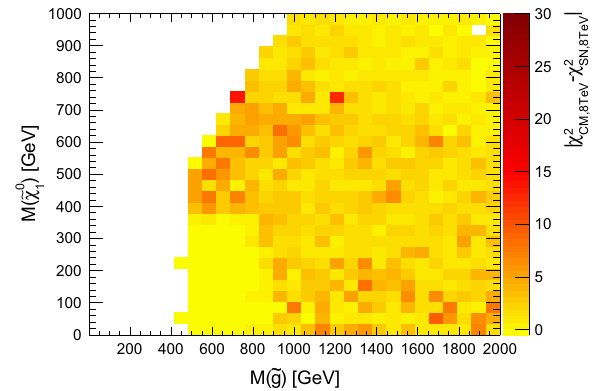
Fig. 15 Difference between the CheckMATE and SCYNet χ 2 predictions in the gluino–neutralino mass plane for all 8 TeV validation points for the reparameterized network. In each bin the mean difference has been calculated for all validation